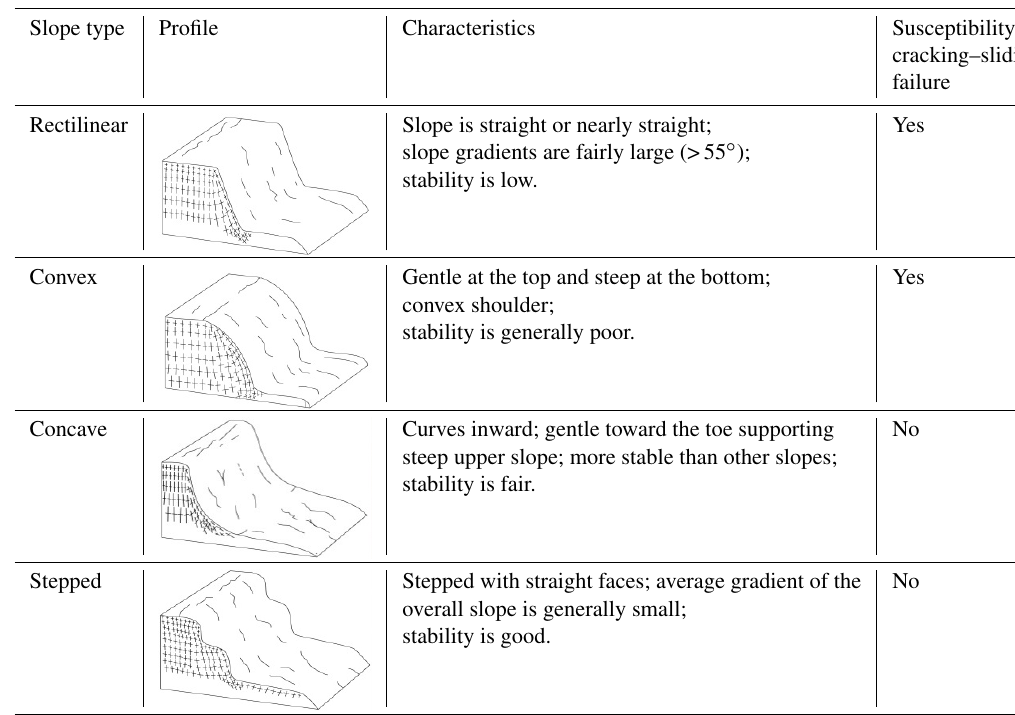
Table 1. Classification of loess slopes.